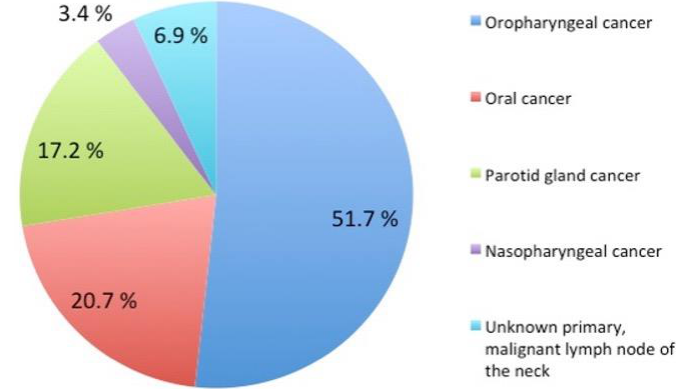
Figure 1. Disease location in patients with head and neck cancer ( n = 29).